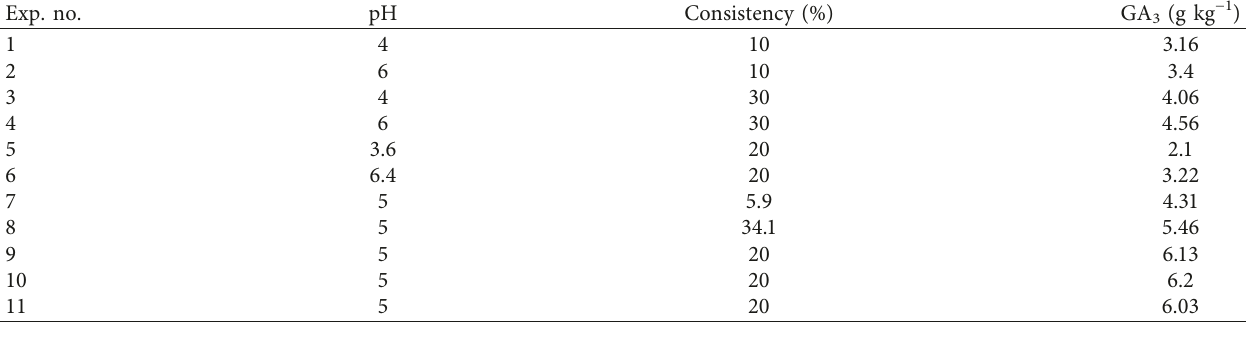
Figure 1: FTIR spectrum of the corn cob sample. Table 2: GA 3 yields obtained from corn cob via SSF in the presence of A . niger.